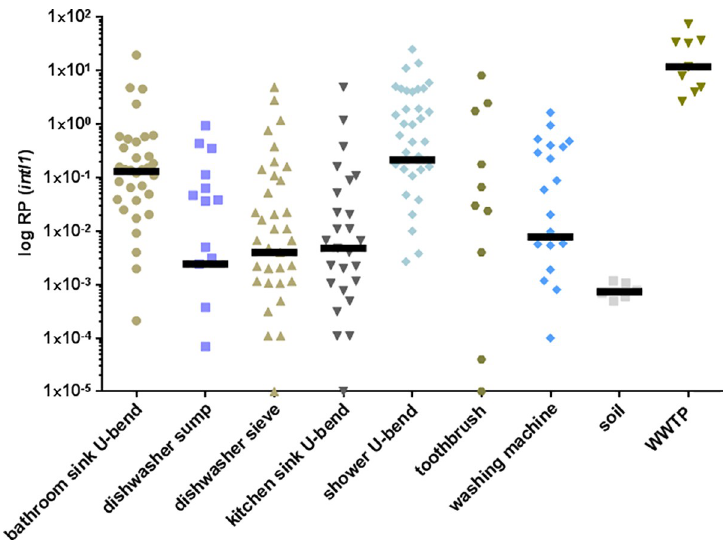
Fig 2. Relative prevalence (RP) of class 1 integrons across households. Bars depict the median. Copies/mL of intI1 and 16S rDNA gene were determined by qPCR and the relative prevalences of intI1 was calculated. Median of households 8, 15, 22 and 27 is